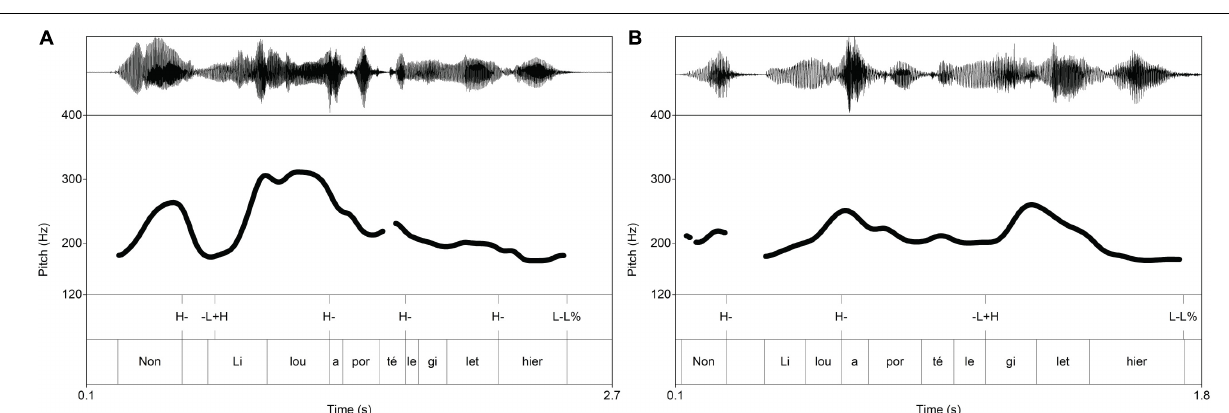
FIGURE 4 | Prosodic realization of (A) subject and (B) object focus in French.